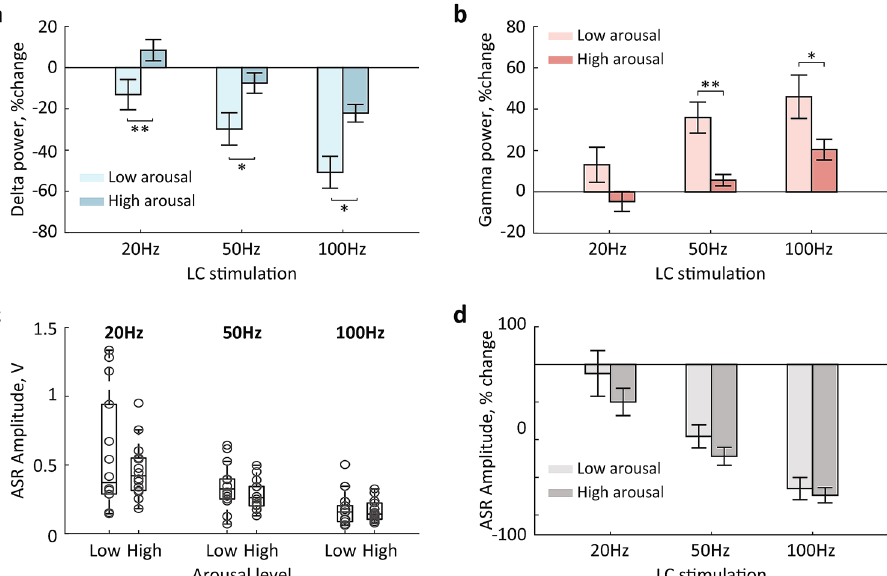
Figure 5. The effects of LC stimulation on the EEG and ASR. ( a , b ) The EEG delta ( a ) and gamma ( b ) power change produced by LC stimulation differed across arousal levels. ( c , d ) The ASR amplitude ( c ) and degree of ASR suppression ( d ) by preceding LC stimulation did not differ across arousal levels. *p < 0.05 and **p < 0.01 (Wilcoxon signed-rank